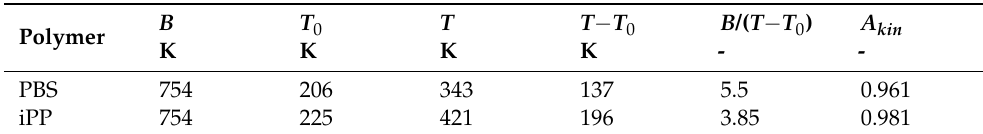
Table 6. Relative change in the nucleation rate due to a change in the kinetic barrier in PBS and iPP at δ T = − 1